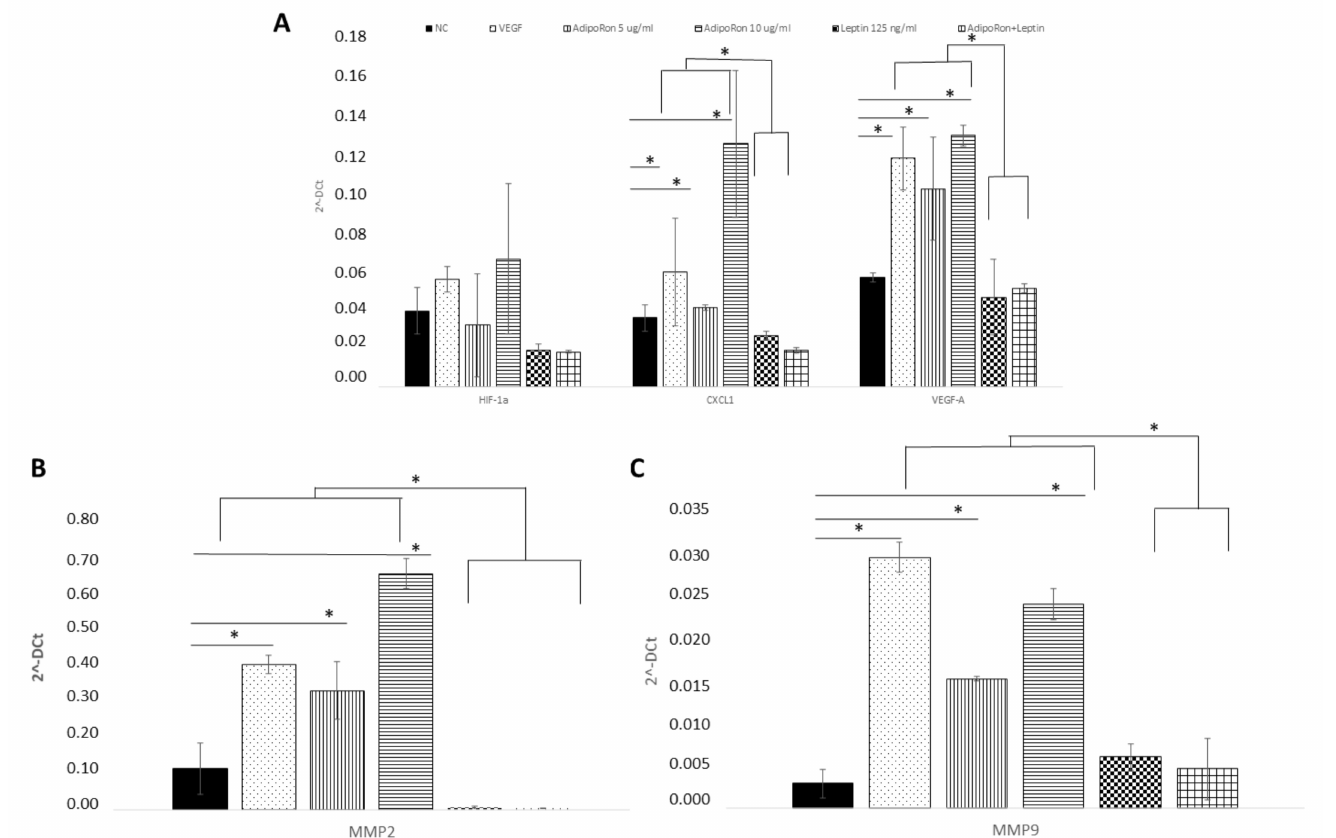
Figure 4. AdipoRon and leptin exert antagonizing effects on HIF-1 α , CXCL1, VEGF-A, ( A ) MMP-2 ( B ) and MMP-9 ( C ) expression. HUVEC endothelial cells were treated with AdipoRon (5 or 10 µ g/mL), Leptin (125 ng/mL) and a combination of AdipoRon+leptin (5 µ g/mL and 125 ng/mL, respectively) for 24 h. Both doses of AdipoRon had effect in increasing the expression of CXCL1, VEGF, MMP2 and MMP9 but not that of H1F1 α . Leptin had no effects as well as the combination of AdipoRon+leptin. Untreated cells were used as negative control (NC); VEGF (10 ng/mL) was used as a positive control. mRNA expression levels were determined by RT-PCR in n = 3 experiments. Data were standardized employing GAPDH and later quantified by 2 − ∆∆ Ct method. * p <